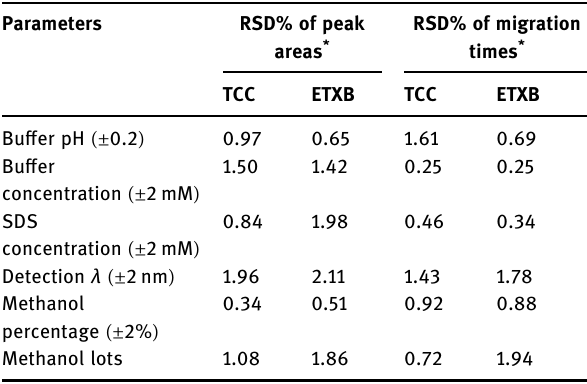
Table 2: Evaluation of robustness of the proposed methods ( n = 9 ) Parameters